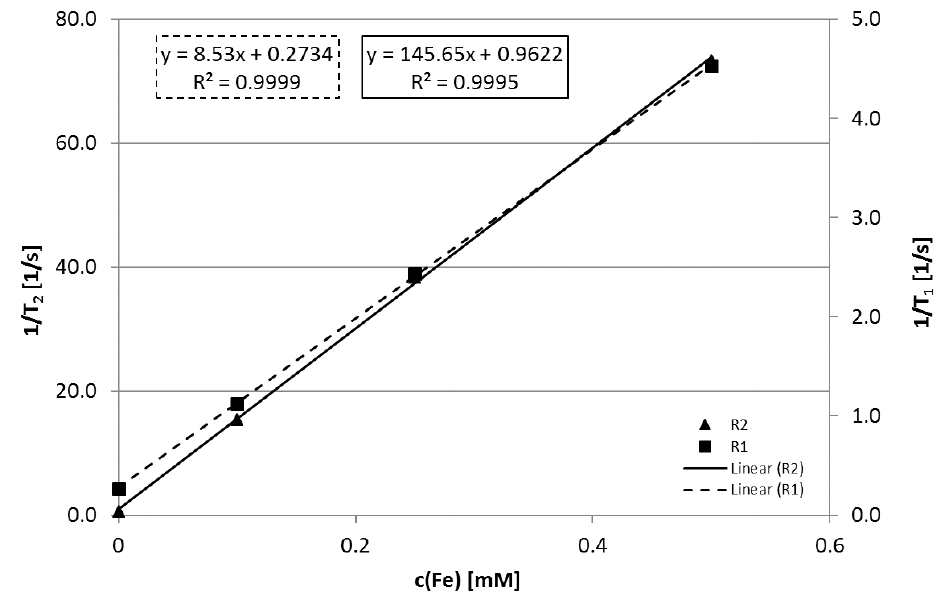
Figure 6. Relationship of the iron concentration c(Fe) in [mM] and the reciprocal of the relaxation time 1/T 1,2 in [1/s]. The relaxivities R1 and R2 were calculated using the slope of the obtained linear equation.